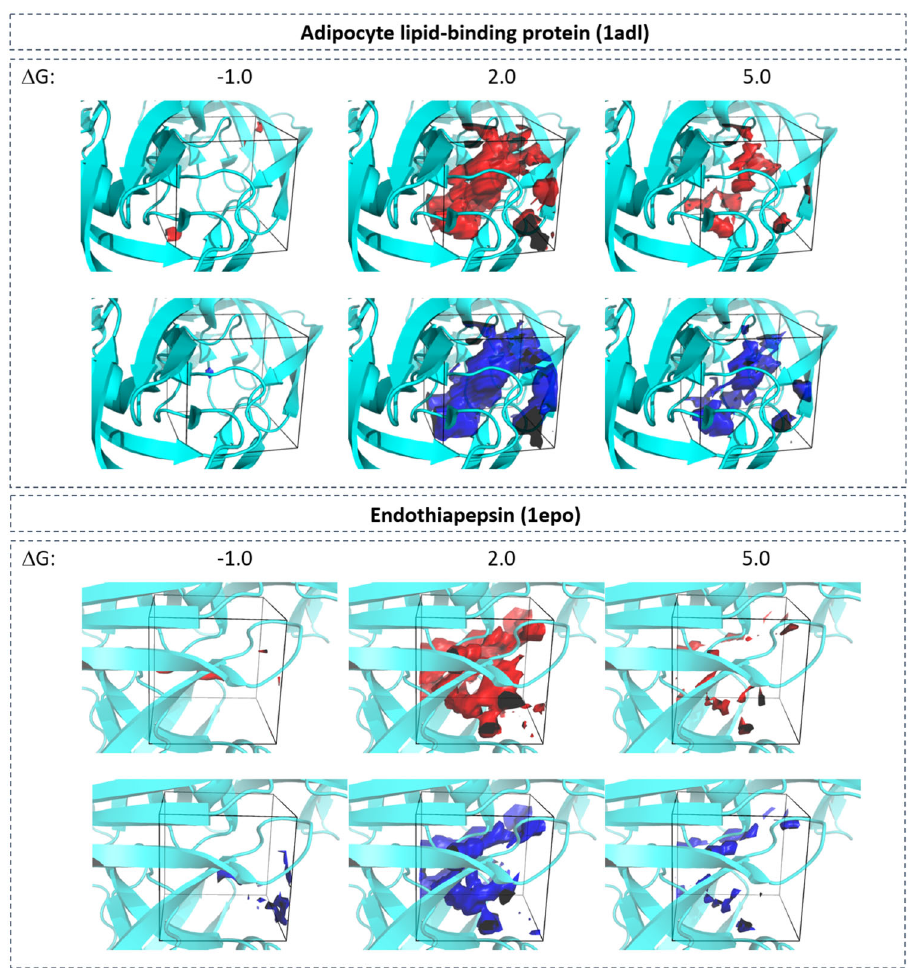
Fig. 9 Accuracy of regression model. Visual comparison between group truth (red) and neural-network predicted (blue) desolvation free energy for adipocyte lipid-binding protein (PDB-code: 1adl) and endothiapepsin (1epo). Predictions were performed using regression neural network. Isosurfaces at three different free energy values ( − 1, 2, and 5 kcal mol − 1 ) are